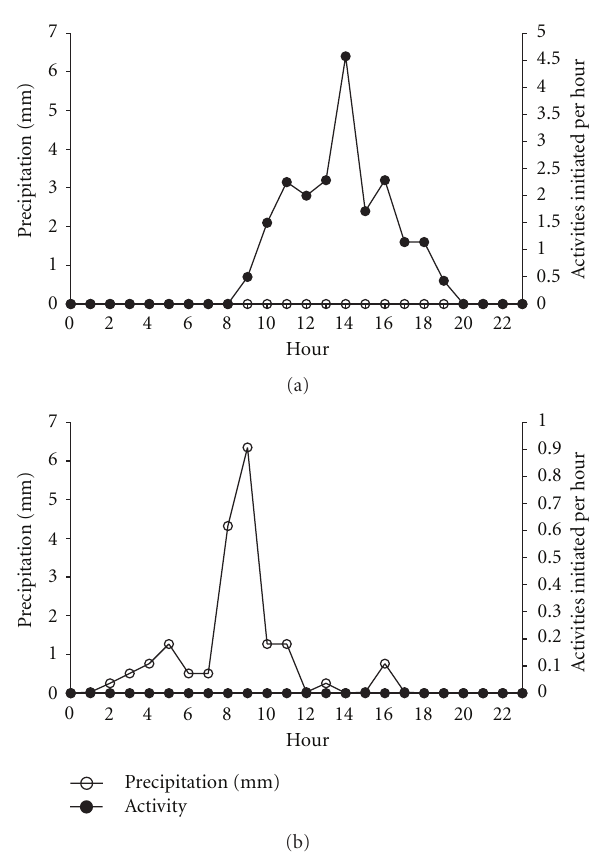
Figure 4: Relationship between O. cornifrons activity and precipi- tation on a day without rain (16 May 2010) (a) and a day with rain (17 May 2010) (b). Hour 0 is 12:00 am and hour 23 is 11:00 pm.